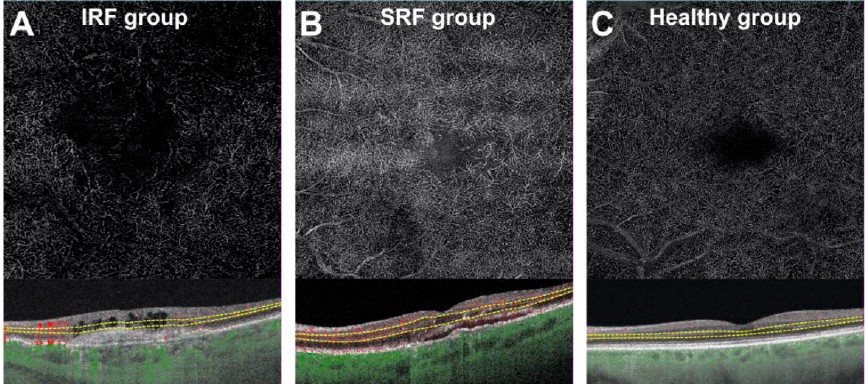
Figure 3. Optical coherence tomography angiography representative images of the deep capillary plexus at T0 in eyes with intraretinal fluid ( A ) and subretinal fluid ( B ) compared to healthy subjects ( C ). Table 4. Mean perfusion density (MPD) in the deep capillary plexus (DCP) according to different factors in the univariate and multivariate